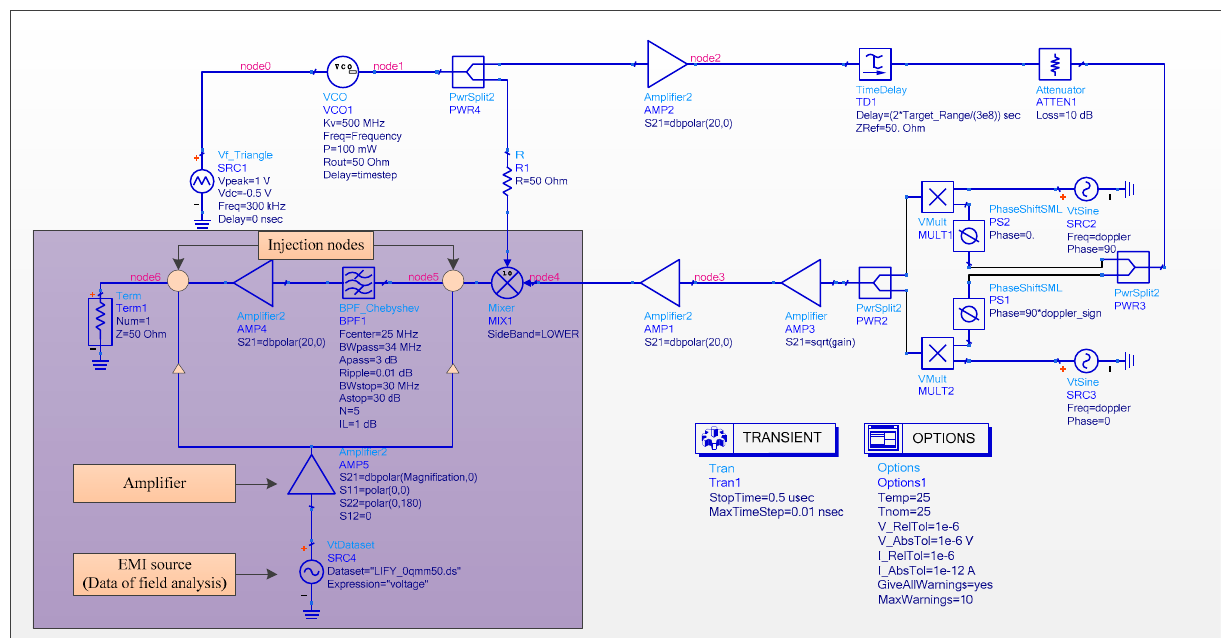
Figure 23. The schematic of the circuit analysis.